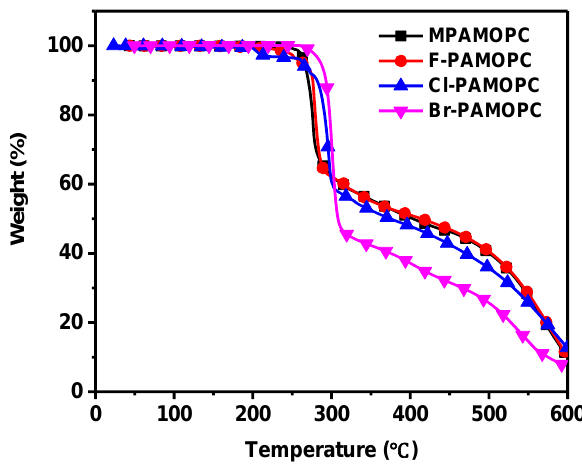
Figure 2. TGA curve of the synthesized azo pyridine derivatives. Table 4. The degradation temperature and molecular weight of newly synthesized compounds.